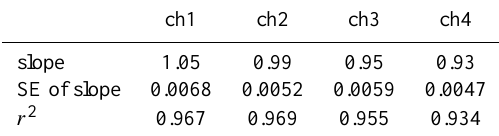
Table 2. Slopes, standard error of slopes and determination co- efficients ( r 2 ) of linear regressions constrained through the origin (model y = mx ) between the “true” CO 2 effluxes (the efflux as cal- culated for the calibration tank) and the efflux rates as measured by the chambers of the new system (Ch1...Ch4). The slopes were used later on (during evaluation of field measurements) as calibration co- efficients.